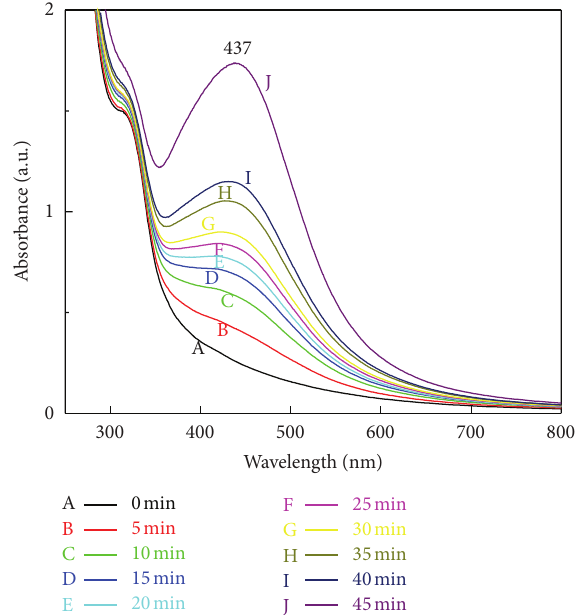
Figure 2: UV-Visible extinction spectra of SNPs recorded after regular time intervals of 5 min up to 45 min; synthesis of SNPs is the function of time.